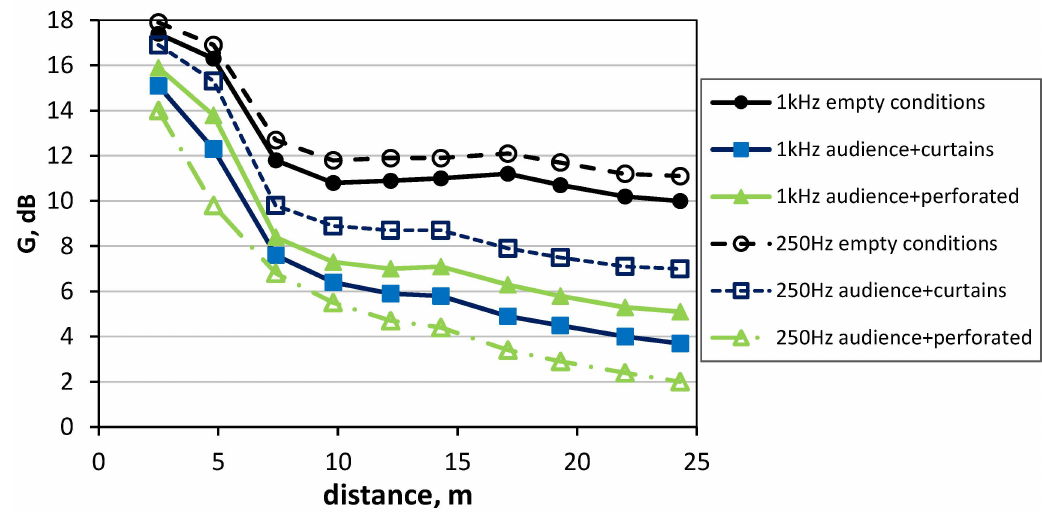
Figure 10. Sound strength (G) at the frequency of 250 Hz and 1 kHz in different